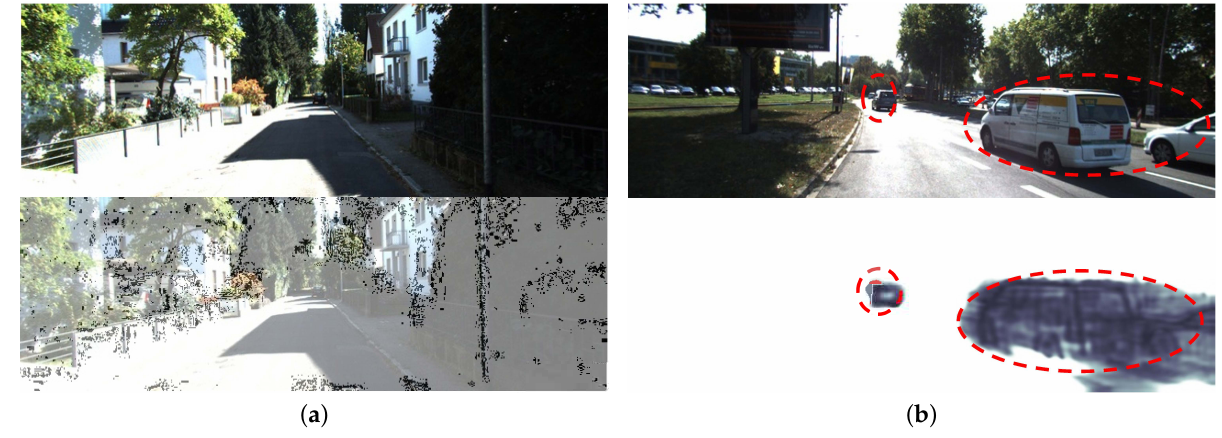
Figure 5. ( a ) occlusion mask ( b ) moving objects mask.